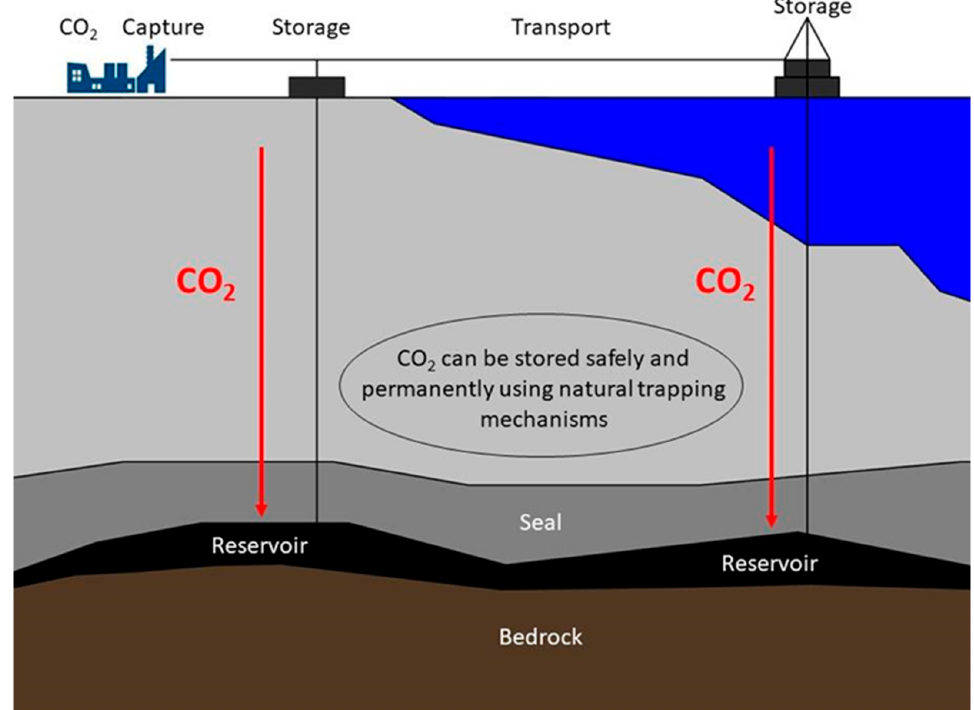
Figure 2. The carbon capture and storage technique. The capture and sequestration process of carbon dioxide before it enters the atmosphere in a geological structure is represented with the red color.